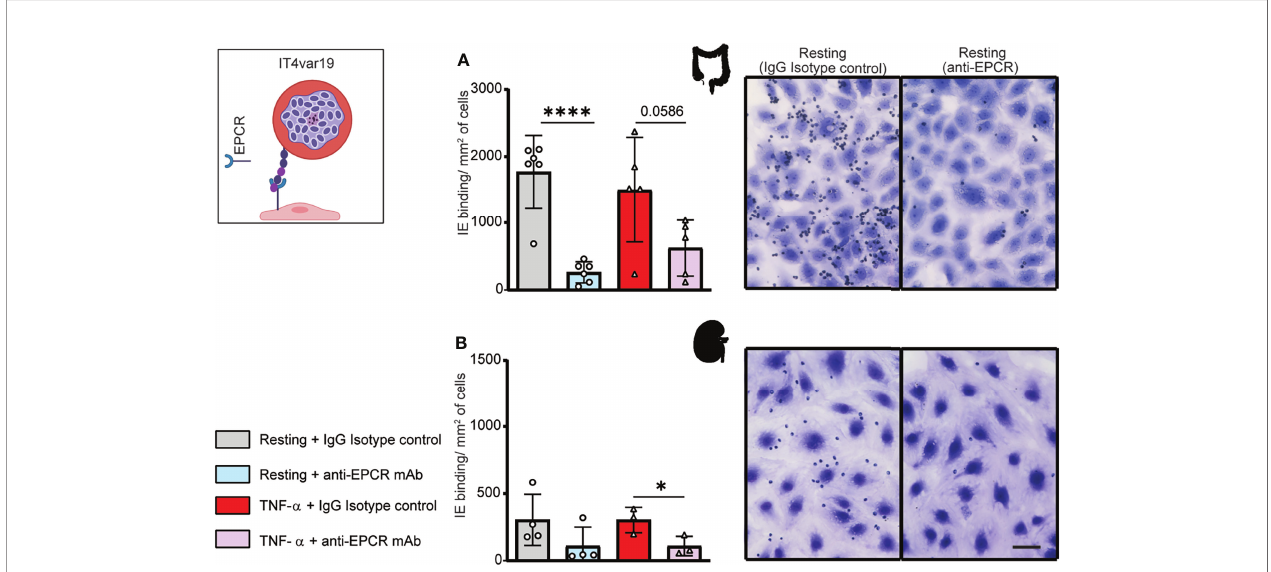
FIGURE 2 | Binding of the IT4var19 clonal parasite line to HIMEC and HKMEC. The IT4var19 parasite was previously selected on brain endothelial cells in vitro and expresses a DC8-PfEMP1 protein that interacts with EPCR on endothelial cells (cartoon). (A) Binding of IT4var19-IEs to resting and TNF- a -stimulated HIMEC cells in the presence or absence of anti-EPCR antibody. (B) Binding of IT4var19-IEs to resting and TNF- a -stimulated HKMEC cells in the presence or absence of anti-EPCR antibody. Data are expressed as mean ± SD and were analyzed by unpaired t test. *p<0.05; ****p<0.0001. EPCR: endothelial protein C receptor. Scale bar: 50 µm. Additional data is shown in Supplementary Figure 3